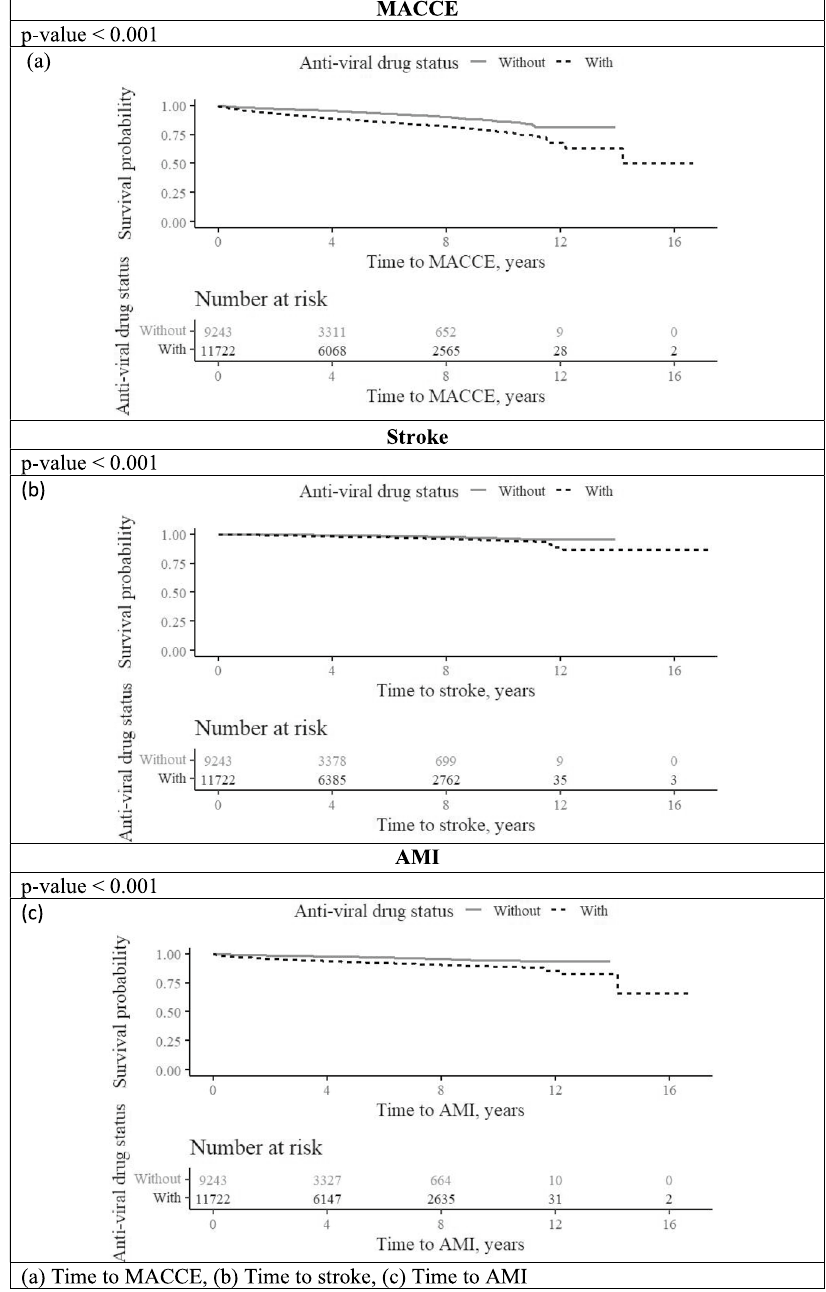
Figure 3. Event-free survival in zoster subjects, by use of antiviral drug one month after exposer to